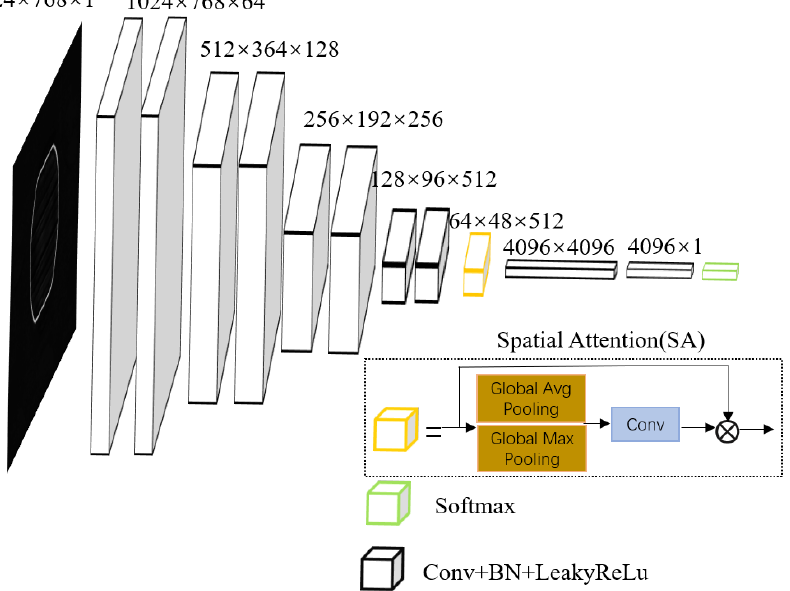
Figure 6. Refinement edge module. The generated result map is input into the discriminator, and the features are extracted through the convolution stack block. Spatial attention is used to pay more attention to the target area. Finally, the input probability is passed through the fully connected layer.